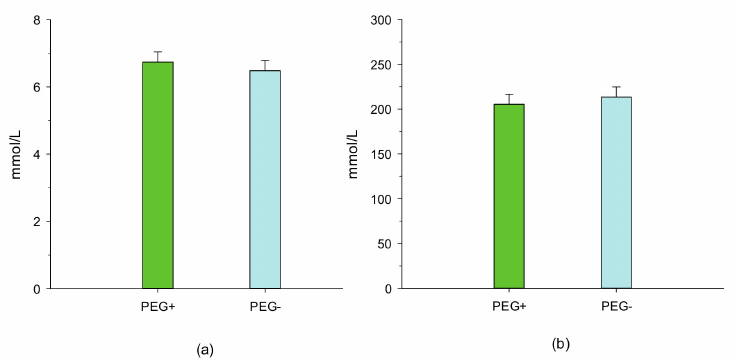
Figure 1. Effect of feeding birdsfoot trefoil diets treated with and without polyethylene glycol on plasma ( a ) ( p = 0.55; SEM = 0.30) and urinary urea ( b ) ( p = 0.61; SEM = 11.2) concentrations of lambs. PEG+, lambs that were fed a basal diet (15% crude protein on a dry matter basis) treated with polyethylene glycol, and PEG − , lambs that were fed a basal diet treated without polyethylene glycol.